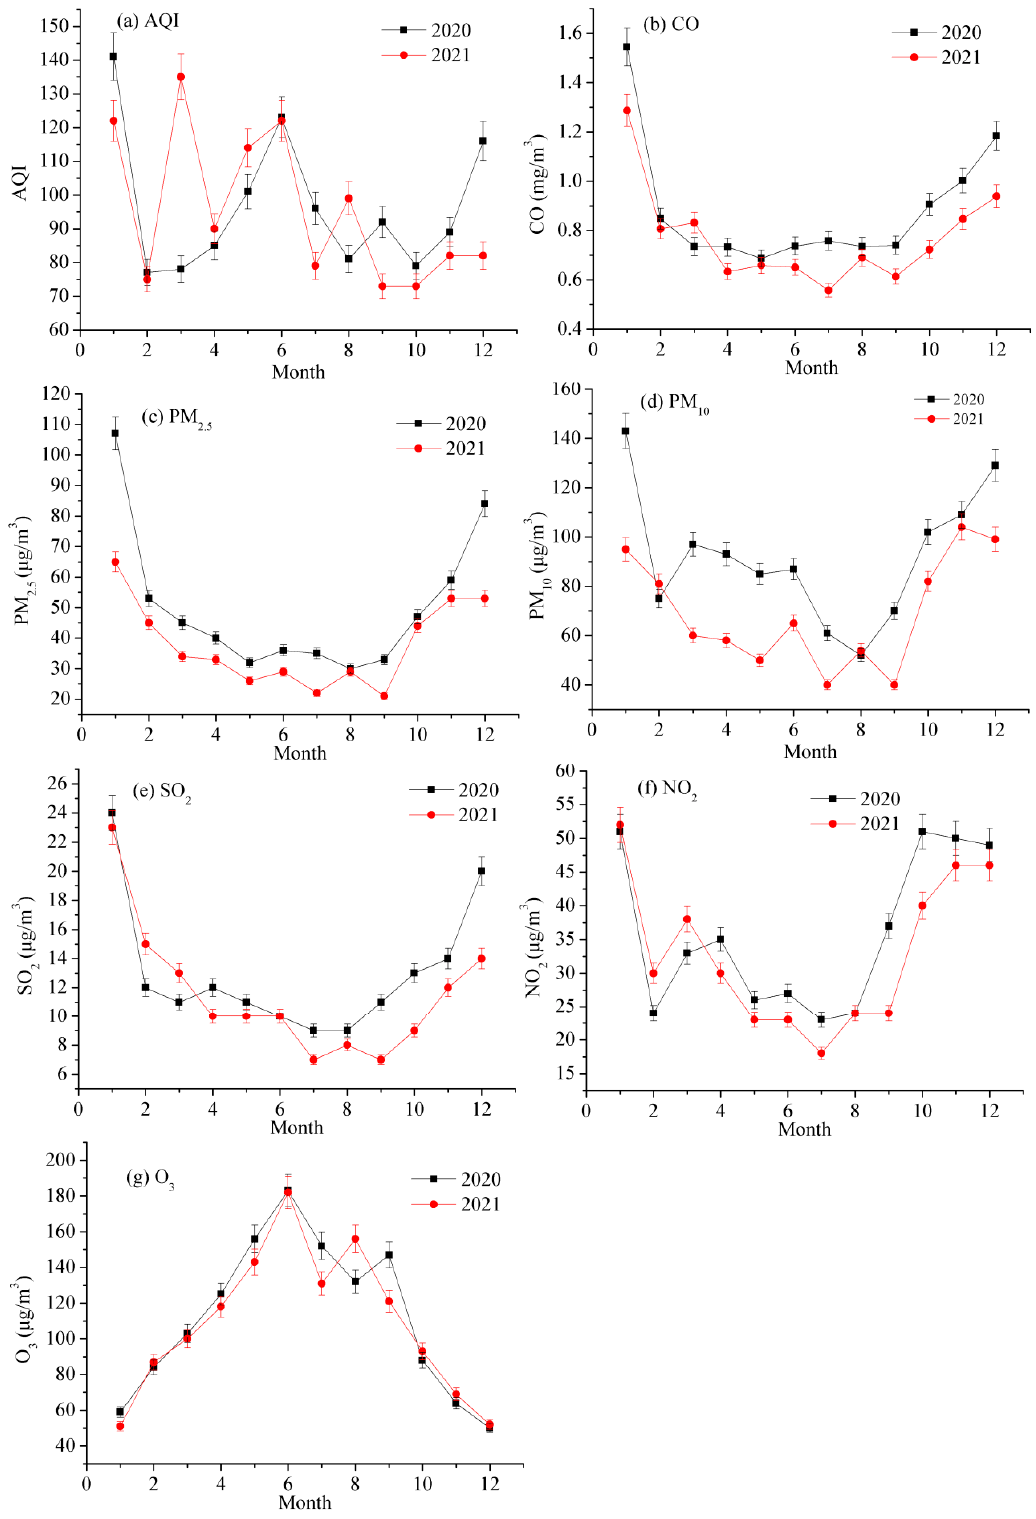
Figure 3. Monthly variations in air quality in Jinan City from 2020 to 2021. ( a ) monthly changes of AQI; ( b ) monthly changes of CO concentrations; ( c ) monthly changes of PM 2.5 concentrations; ( d ) monthly changes of PM 10 concentrations; ( e ) monthly changes of SO 2 concentrations; ( f ) monthly changes of NO 2 concentrations; ( g ) monthly changes of O 3 concentrations.